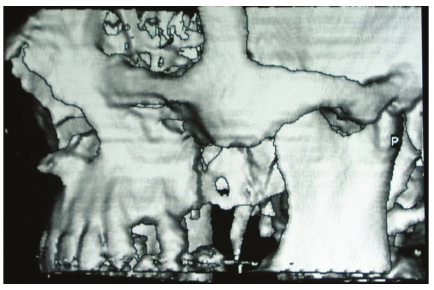
Figure 1: Ct scan view.